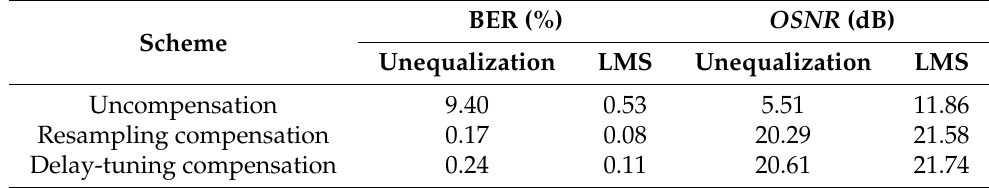
Table 5. The coded BER and OSNR under different communication schemes at unequalization and LMS equalizer conditions for lake experiment.